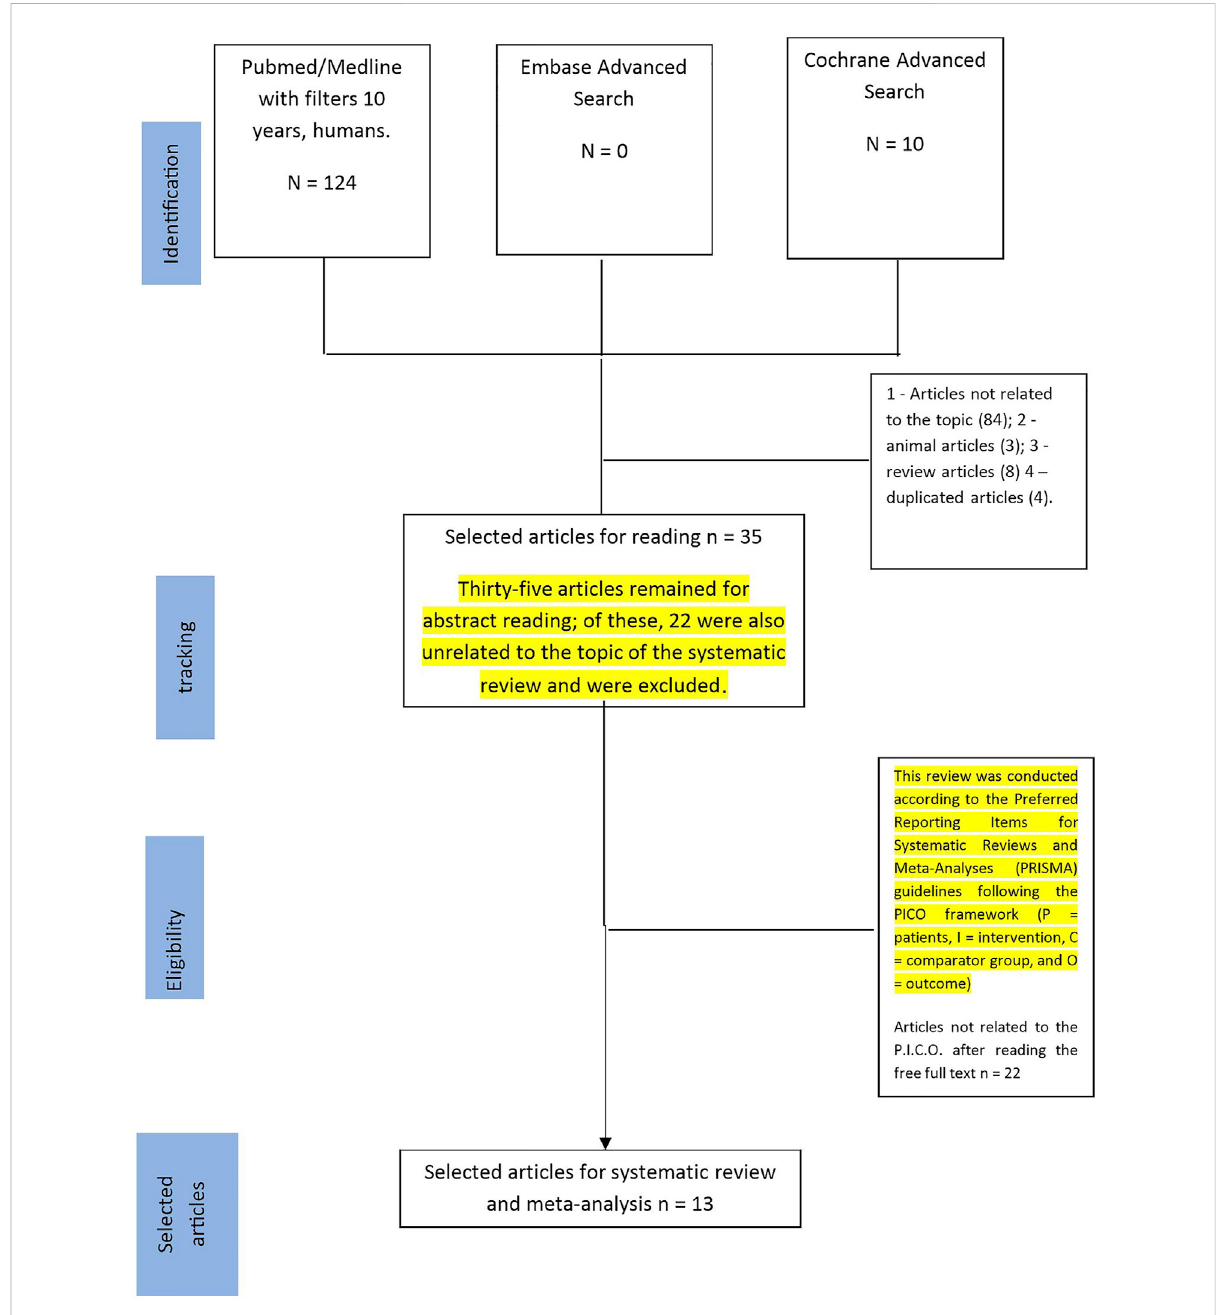
FIGURE 1 Flowchart for selection of